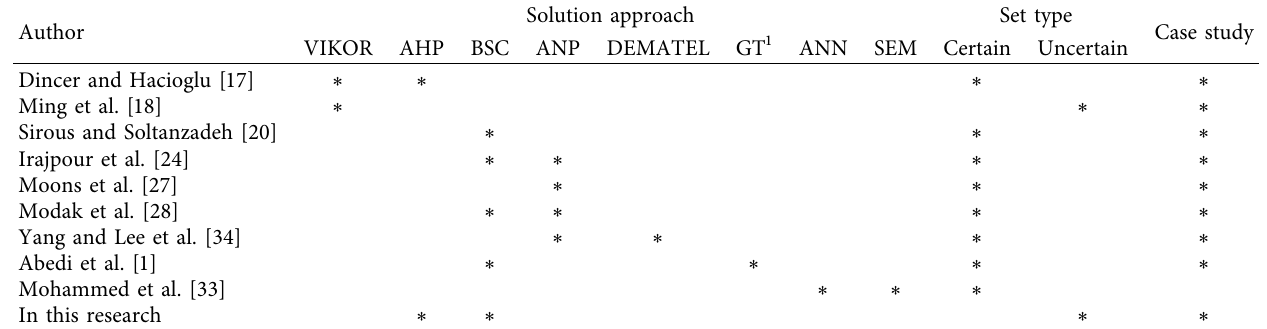
Table 1: Literature categorized.